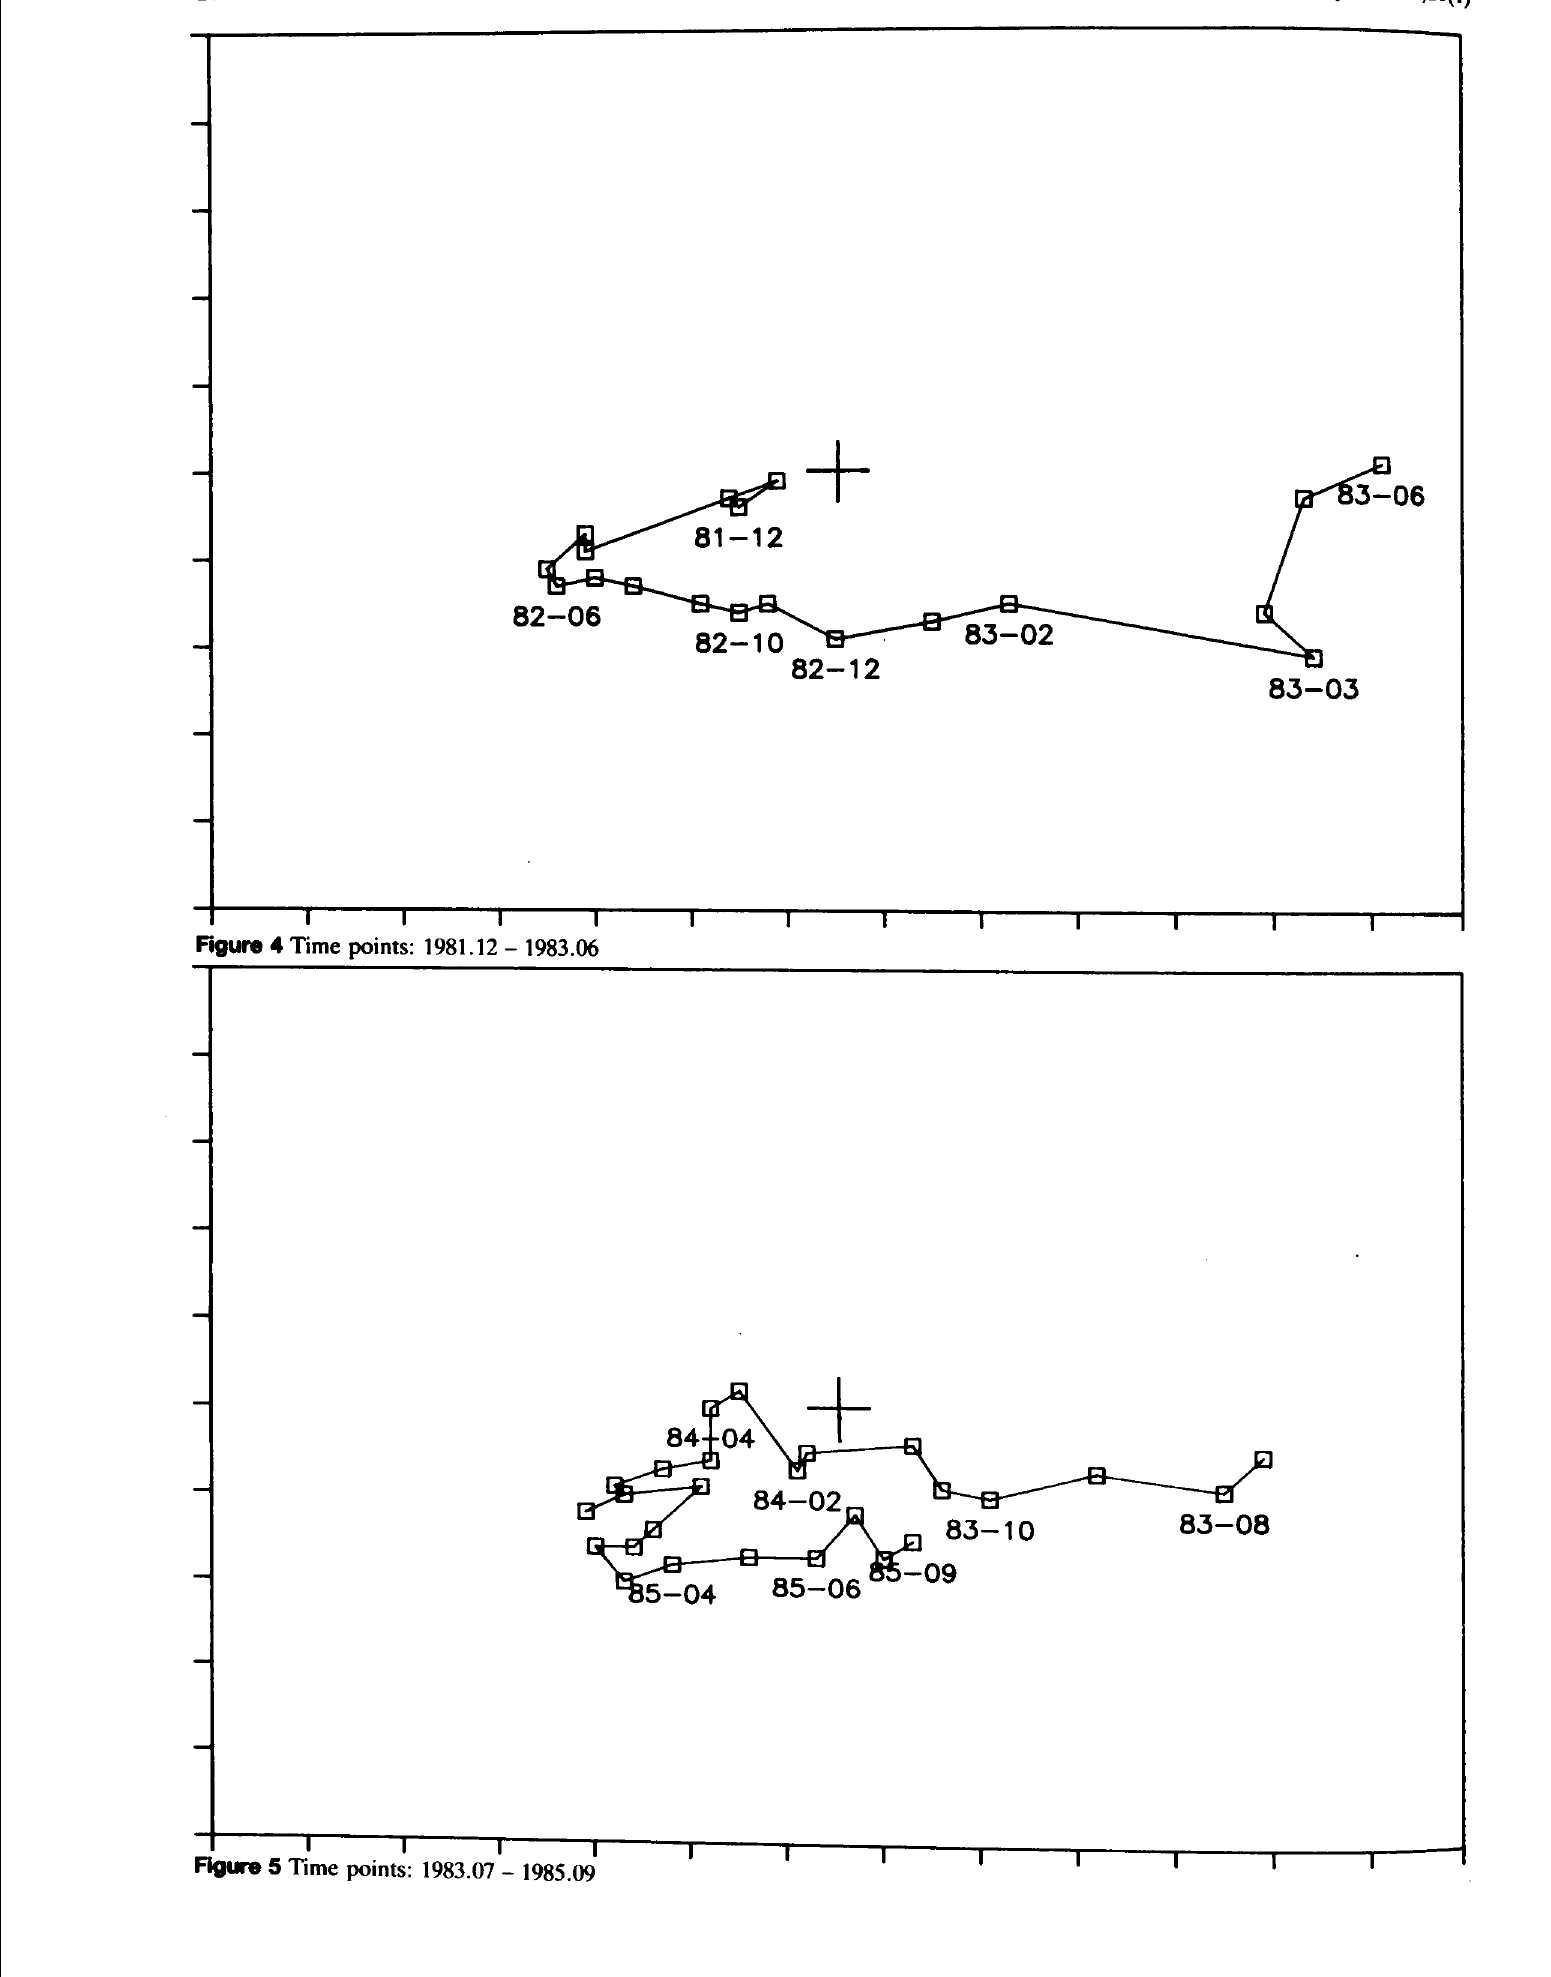
Fig&n 5 Time points: 1983.07 -